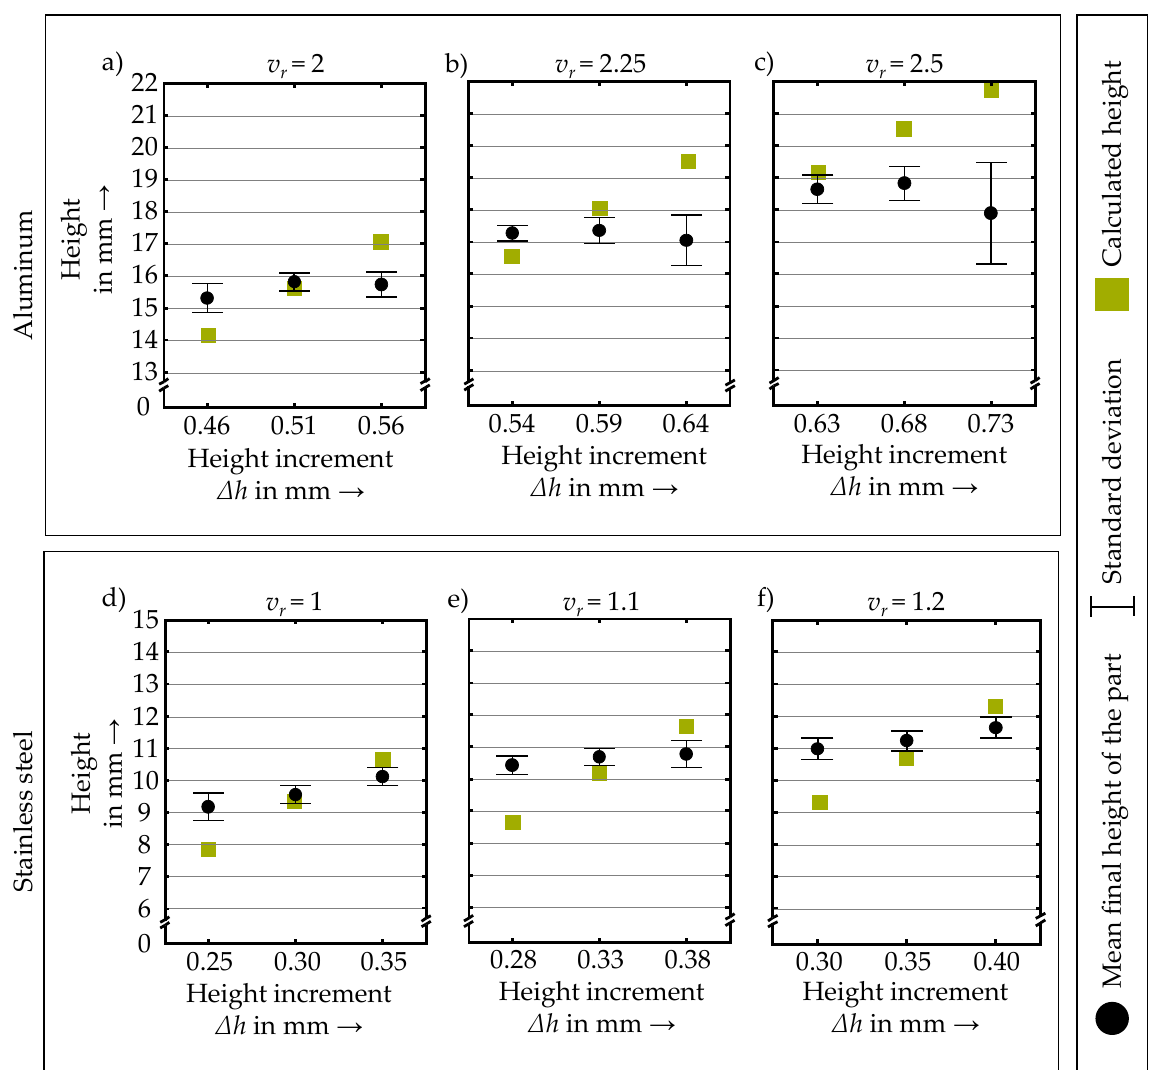
Figure 10. Height of the produced cylinders with a fixed speed ratio as indicated at the top of the respective diagrams and three different height increments for aluminum ( a – c ) and stainless steel ( d – f ).